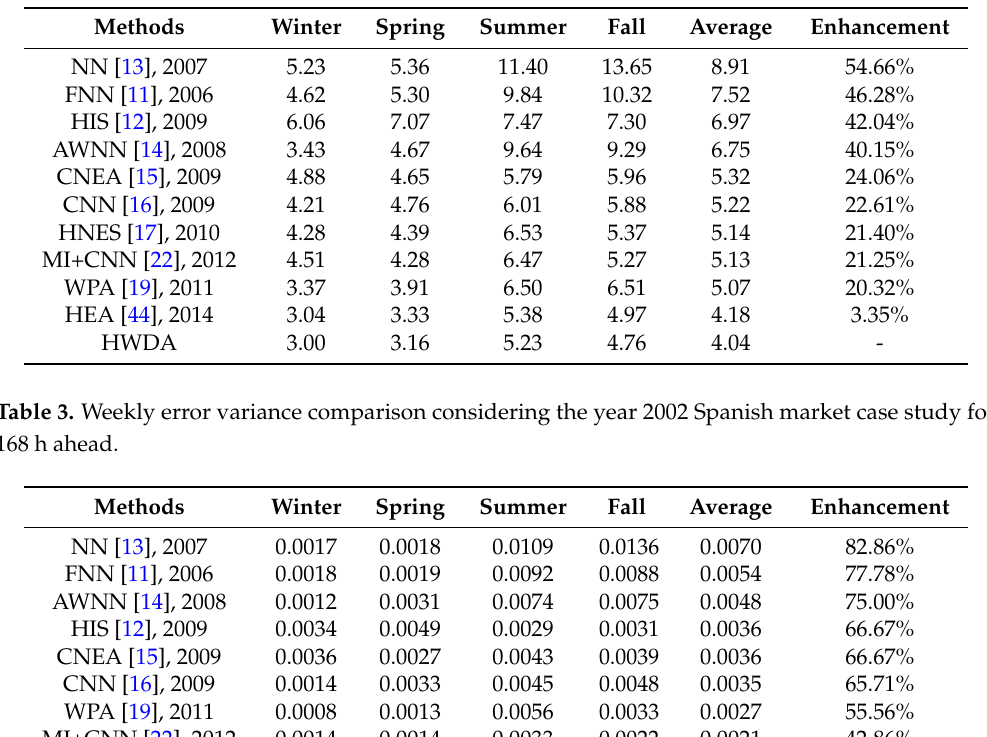
Table 2. MAPE (the mean absolute percentage error) comparison considering the year 2002 Spanish market case study for 168 h ahead.